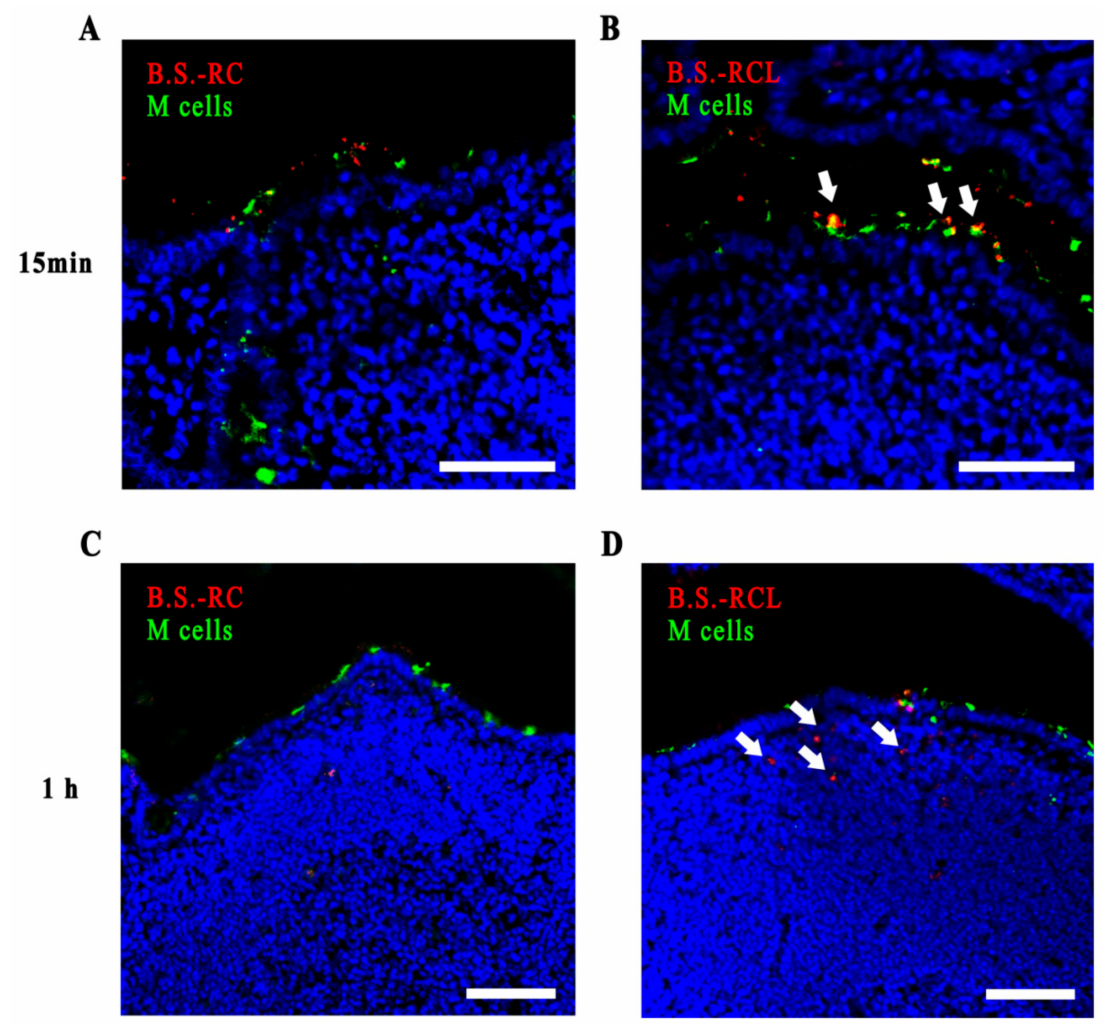
Figure 4. The observation of co-located M cells and recombinant B. subtilis . The ligated loops of mice were injected with Dylight 488-labelled B. subtilis RC and Dylight 488-labelled B. subtilis RCL for 15 min and 1 h, respectively. Frozen sections of the ileum were stained with UEA-1 (green) and DAPI (blue). ( A , B ) The co-located M cells and Dylight 549-labelled B. subtilis RC or B. subtilis RCL (white arrows) 15 min after recombinant B. subtilis injection. ( C , D ) The co-located M cells and Dylight 549-labelled B. subtilis RC or B. subtilis RCL (white arrows) 1 h after recombinant B. subtilis injection. Scale bars = 10 µ